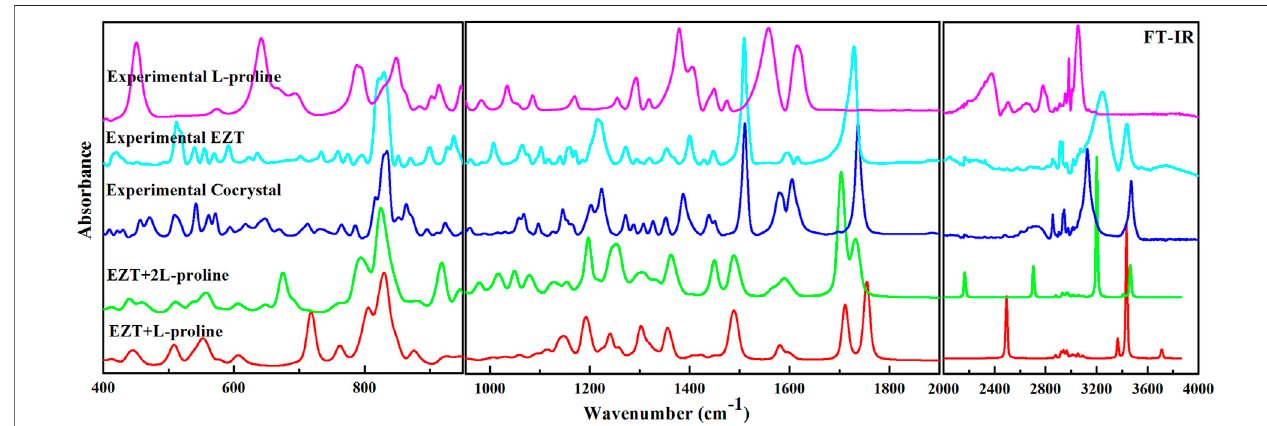
FIGURE3 | Experimental FTIR spectra ofEZT- L -proline, EZT, and L -proline with calculated IRspectra ofthecocrystal(EZT + L-proline and EZT+ 2L-proline) in the regions 400 – 1,000, 1,000 – 2,000, and 2,200 – 4,000 cm − 1 .